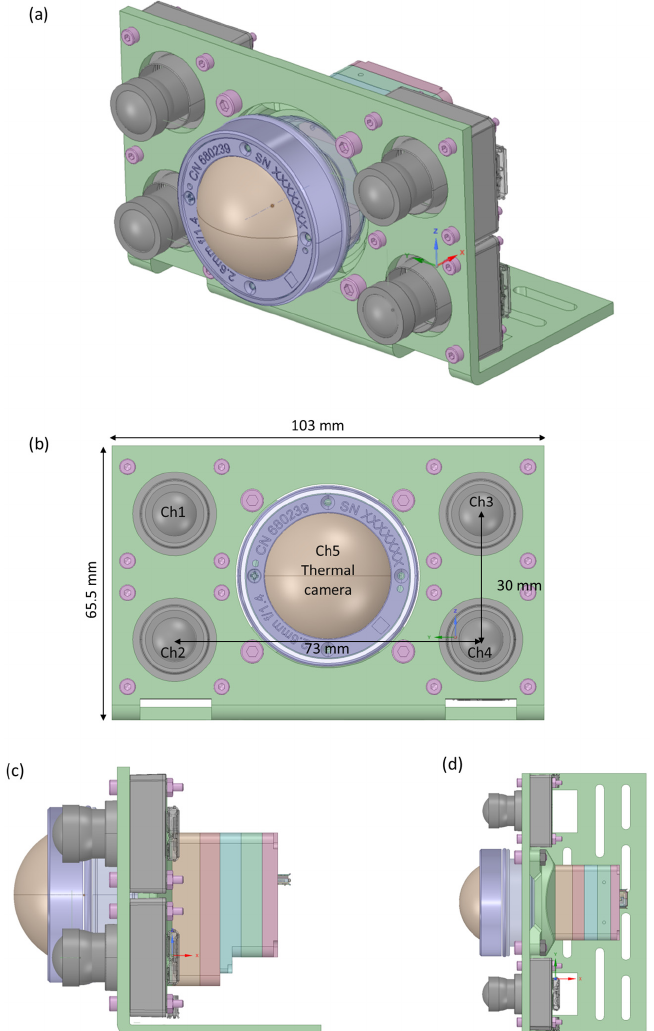
Figure 4. Layout of the 5-channel camera design: ( a ) 3D view, ( b ) front view indicating the position of the thermal camera in the center surrounded by the visible and NIR imaging channels, ( c ) side view indicating the mounting of the imaging sensors, ( d ) top view.